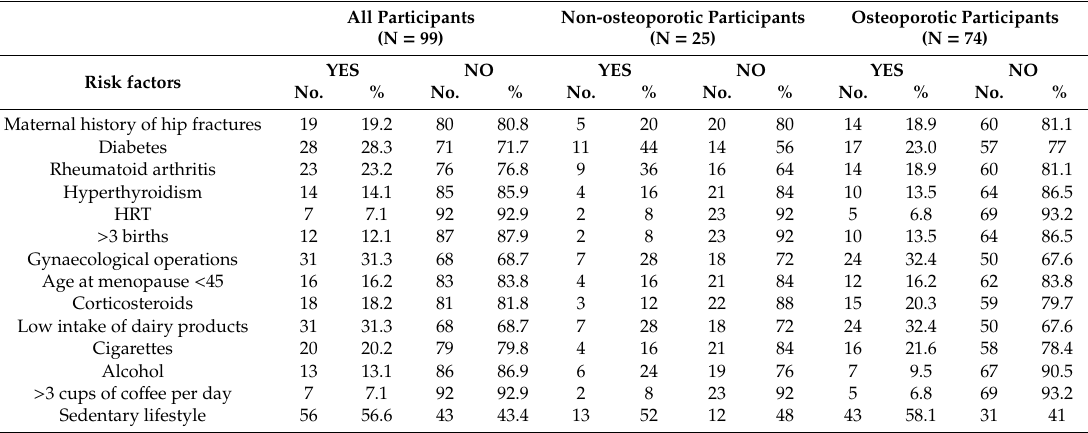
Table 2. The numbers and percentages of participants a ff ected by particular risk factors for osteoporosis.